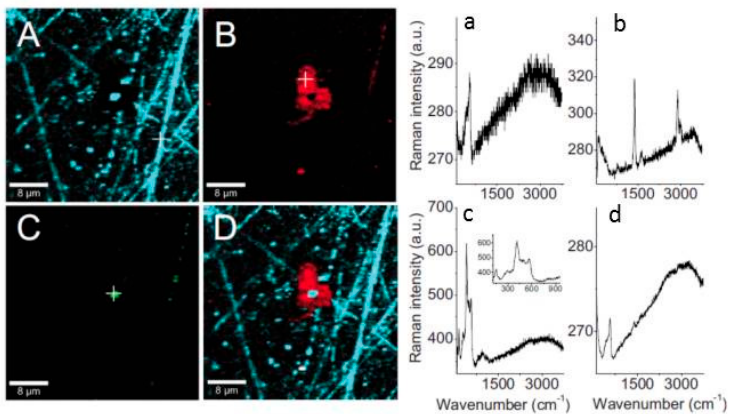
Figure 13. Left: Color-coded Raman images for zinc exposed to 100 ppb formic acid in humid air (90% RH) for 2 h. ( A ) ZnO (300–620 cm − 1 ); ( B ) CH in Zn hydroxy formate (2850–3000 cm − 1 ); ( C ) The region 380–480 cm − 1 ; ( D ) The combination of the Raman images in A – C . Right panel ( a – c ): Raman spectra corresponding to the marked spots in the color-coded images; ( d ) is the average over the whole image. Image size 40 × 40 μ m. The Raman images were collected ex situ. Reproduced from reference [106] by permission of The electrochemical Society. Copyright 2010.